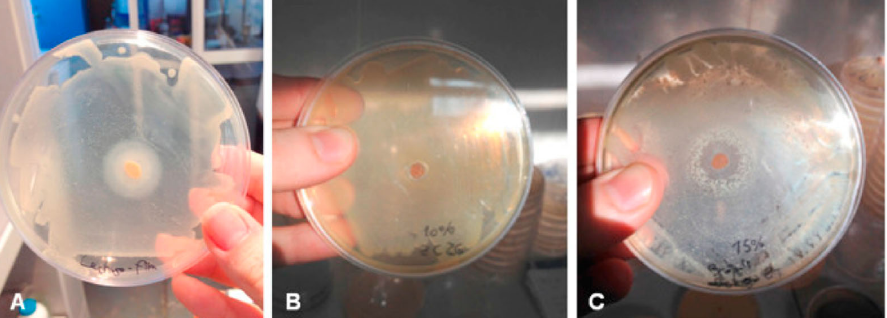
Figure 7. Radial disk diffusion assay on ( A ) lettuce microflora film of control; ( B ) film with 10% thyme essential oil in the presence of Escherichia coli and ( C ) film with 15% thyme essential oil against broccoli microflora (reproduced with copyright permission from Chen et al. [24]).